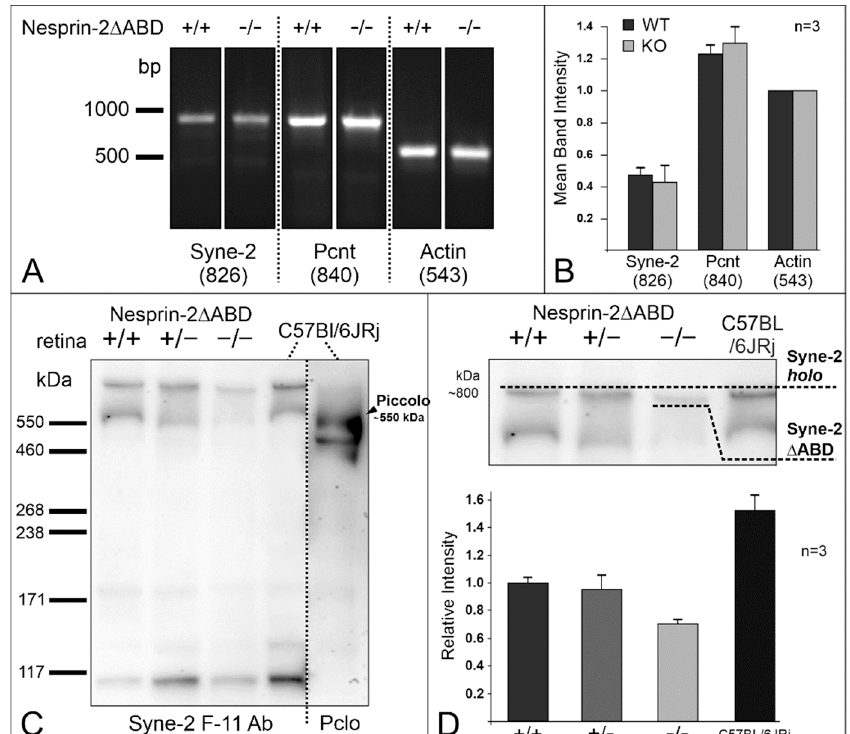
Figure 6. Expression of Syne-2 in Syne-2/Nesprin-2 KO retinae (age 2–4 months). ( A ) RT-PCR made with cDNA from Syne-2/Nesprin-2 KO and wild-type (WT) mouse retinae using specific primer sets for Syne-2, Pcnt, and β -actin (positive control). Syne-2 (aa residues 1921–2066) and Pcnt (aa residues 917–1169) are expressed in WT and KO retinae. The β -actin positive control demonstrates the approximate amount and the quality of the used cDNA. ( B ) Intensity measurements ( n = 3) show an unchanged mRNA expression level of Syne-2 and Pcnt in Syne-2/Nesprin-2 KO and WT mouse retina with respect to the β -actin control. ( C ) Protein expression of Syne-2 in the mouse retina of C57BL/6JRj and in the different genotypes of the Syne-2/Nesprin-2 KO mouse line. Western blot analysis using the Syne-2 C-term antibody detect the full-length Syne-2 (~800 kDa), a splice-variant about 550 and 110 kDa in all Syne-2/Nesprin-2 KO phenotypes. An anti-Piccolo antibody was used for validating protein sizes detecting Piccolo (550 kDa). ( D ) Mean band intensity measurements of Western blot bands (stain-free imaging technology, BioRad) show a comparable expression level of full-length Syne-2 in all Syne-2/Nesprin-2 KO phenotypes, however, protein sizes varied. Retina extracts from the KO mouse show the presence of a Syne-2 protein with lower molecular weight than wild-type and heterozygous Syne-2/Nesprin-2 KO retina extracts implicating the expression of a smaller protein variant lacking the N-terminal part of Syne-2 ( n = 3).